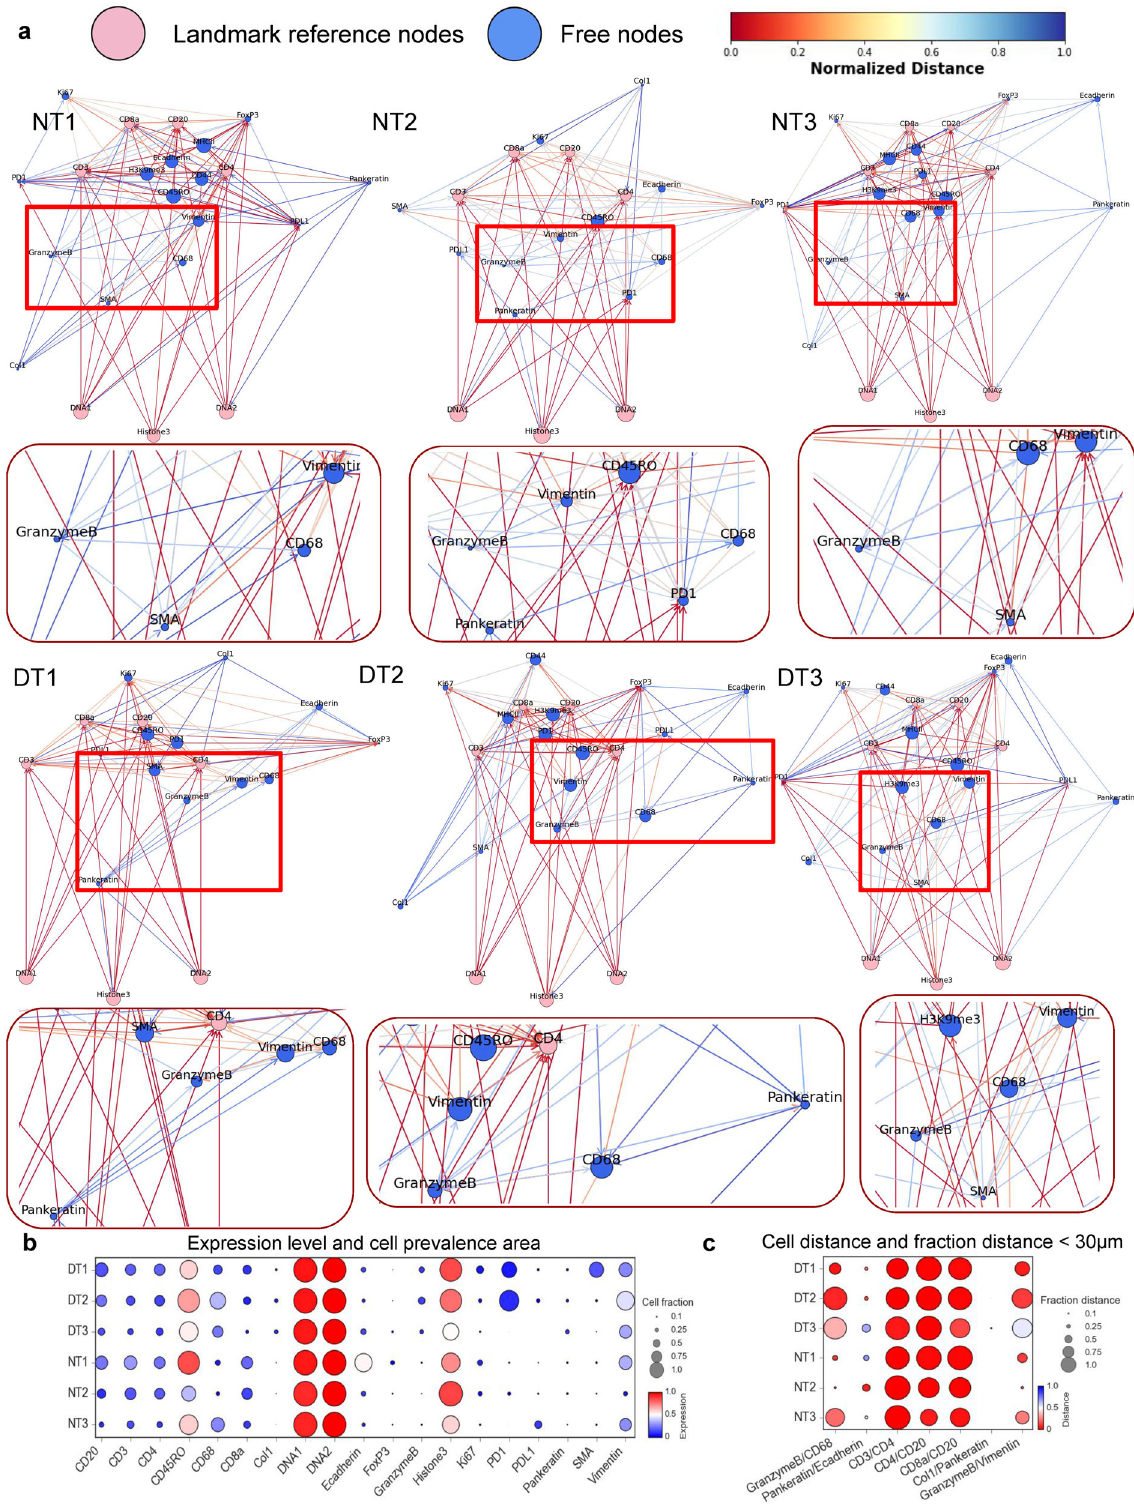
solution for additional 20 min at room temperature. The samples were then dried, and a PAP pen was used to draw a hydrophobic barrier around the specimen on the slide. After this step, a serum-free, ready-to-use protein blocking buffer (Cat- alog number: X090930-2, Agilent Dako) was applied to the sample for 30 min at room temperature. After three washes of Maxpar PBS (Catalog number: 201058, Fluidigm), the tonsil tissues were then stained with a metal-conjugated